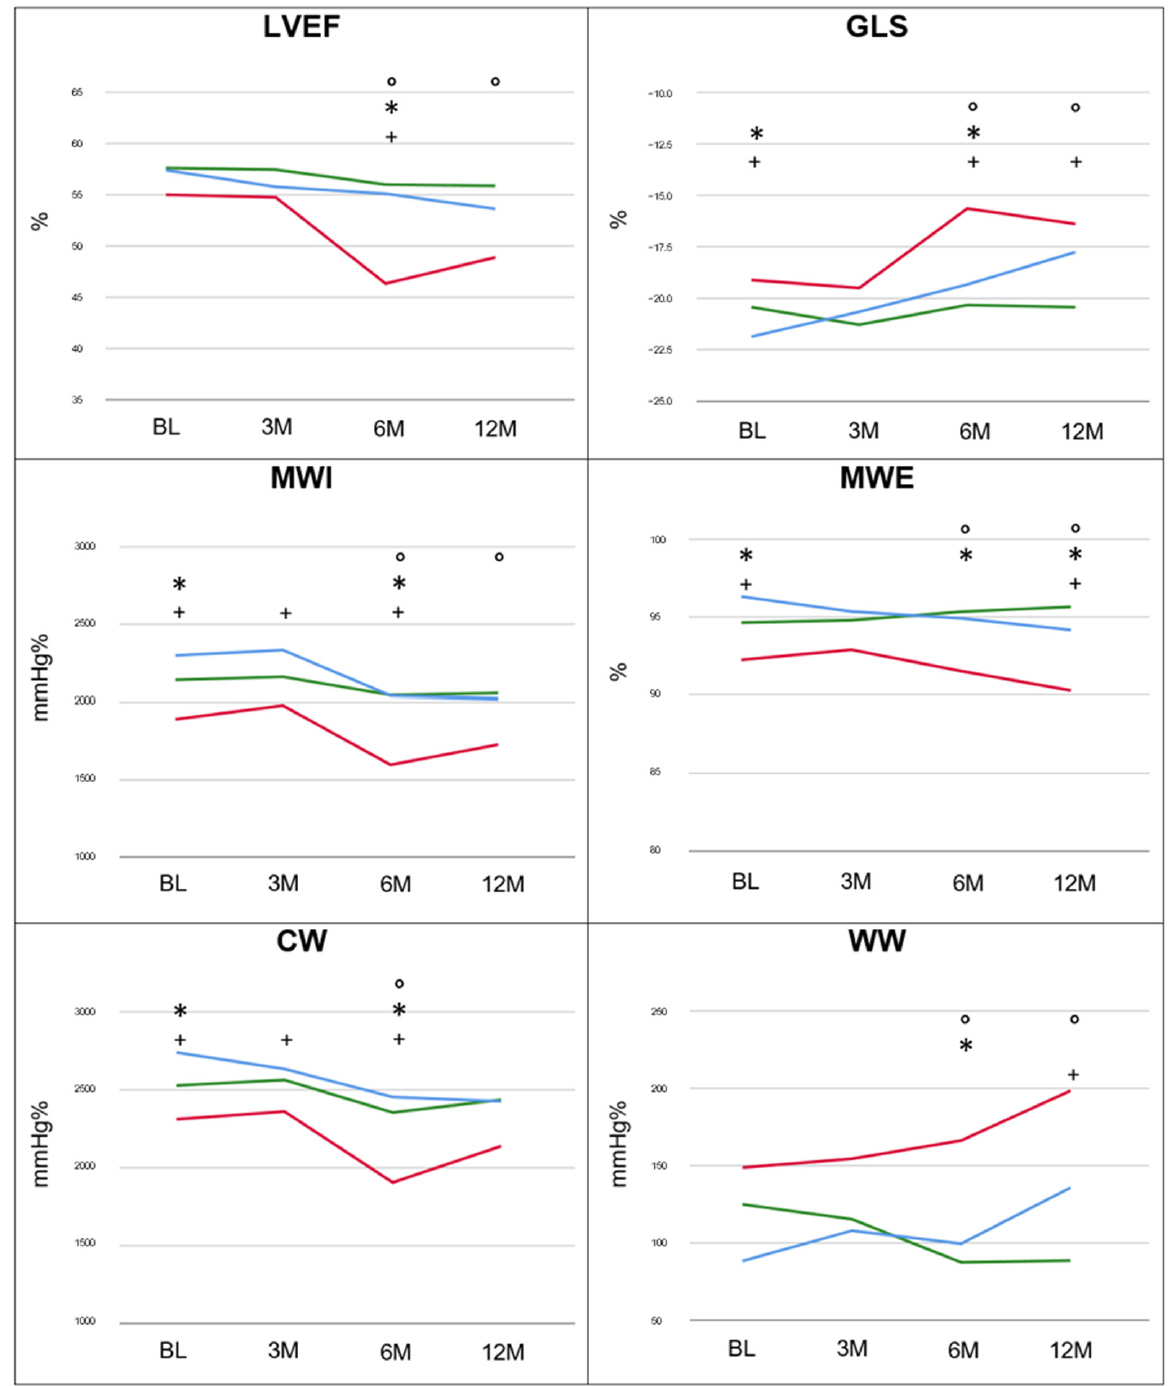
Figure 1. Temporal changes and trajectories of LVEF, GLS and MW indices in CTRCD neg (green), CTRCD mild (blue) and CTRCD mod (red) group. ° CTRCD mod vs. CTRCD neg ; * CTRCD mod vs. CTRCD mild ; + CTRCD mod vs. CTRCD neg + mild ; p ≤ 0.05.